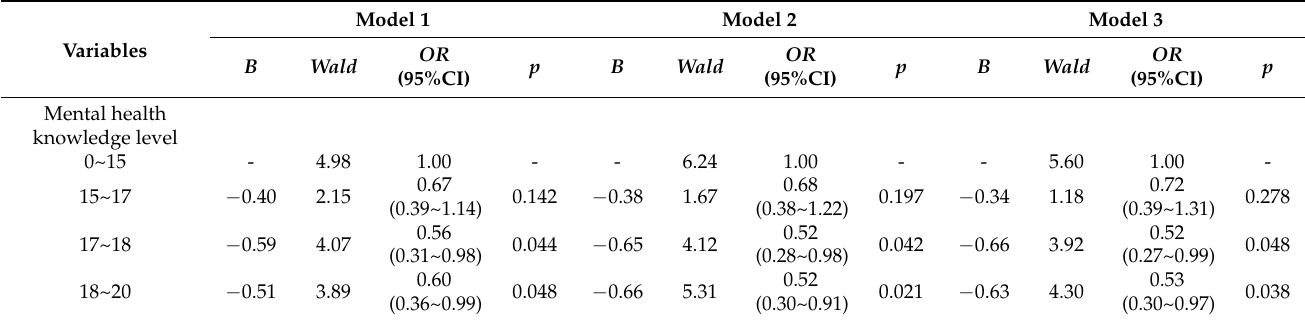
Table 3. Logistic regression analysis of the association between mental health knowledge level and depressive symptoms among college